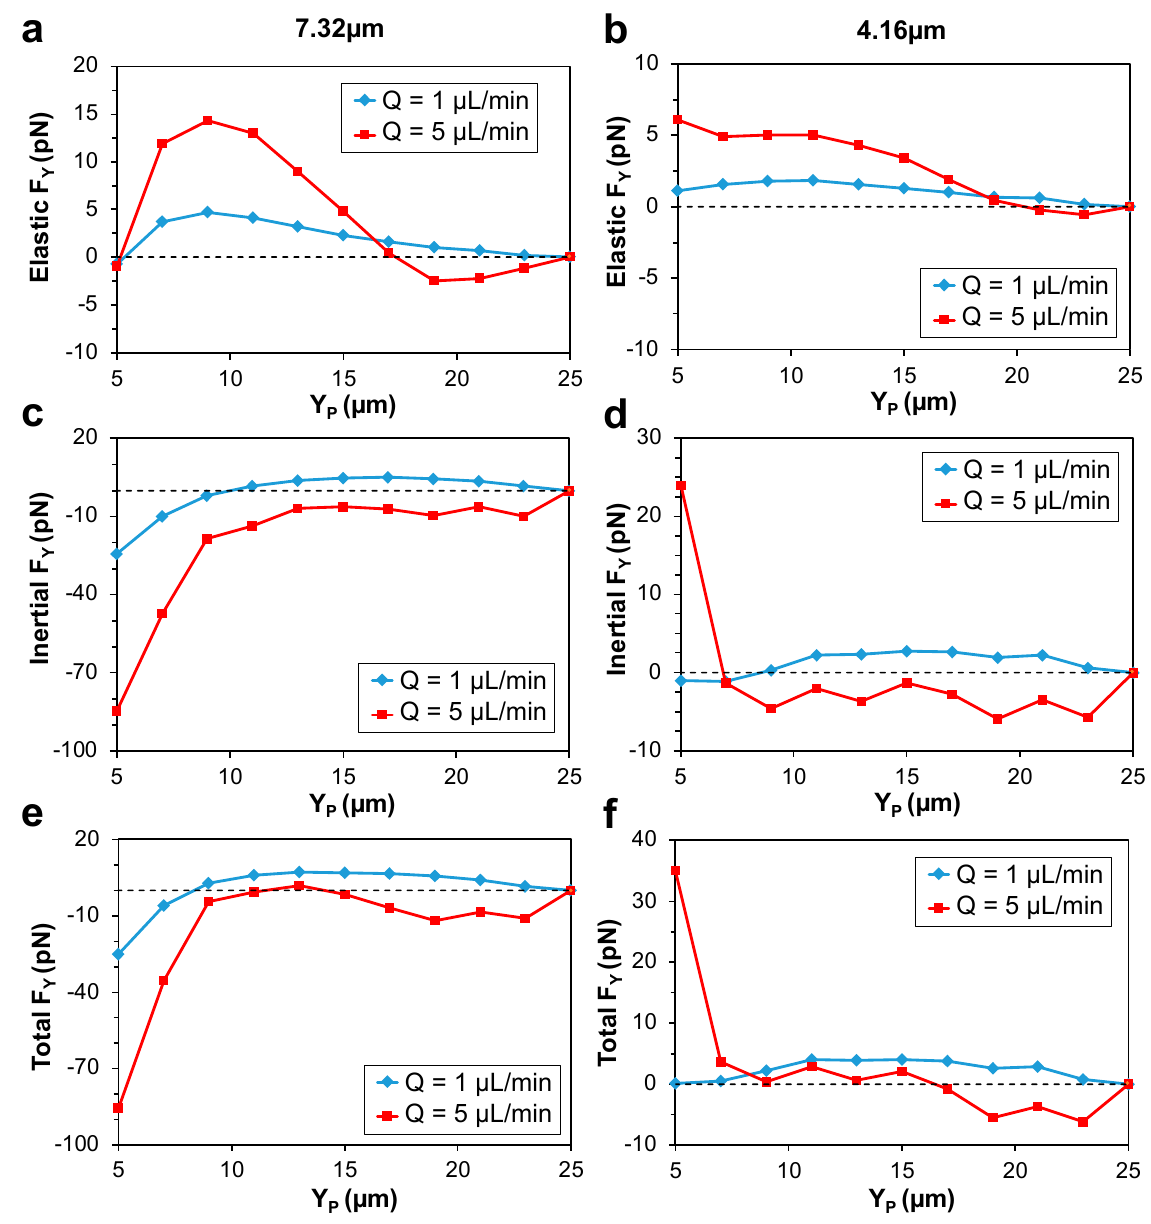
Figure 5. Horizontal force (F Y ) distribution along the Y-midline of the channel. Elastic force profile for the ( a ) 7.32 µm and ( b ) 4.16 µm diameter particles at Q = 1 µL/min ( Wi = 3.6) and Q = 5 µL/min ( Wi = 18). Inertial force profiles for the ( c ) 7.32 µm and ( d ) 4.16 µm diameter particles at the two flowrates. Total force profiles for the ( e ) 7.32 µm and ( f ) 4.16 µm diameter particles at the two flowrates.